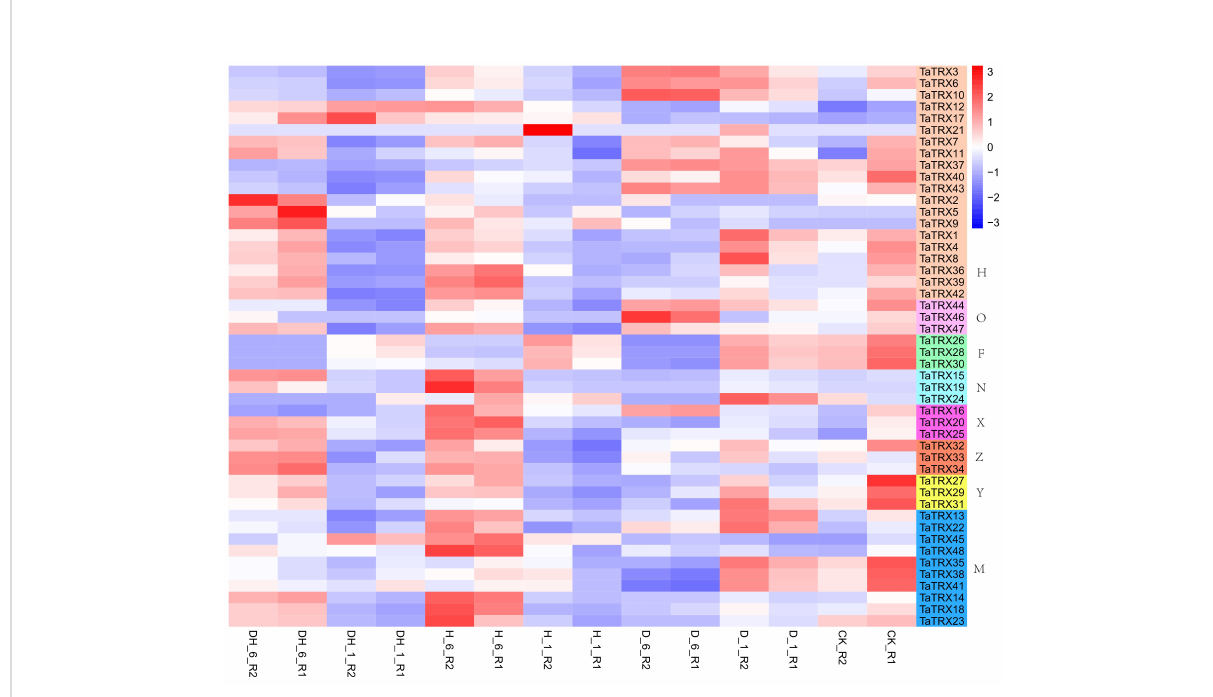
FIGURE 6 Expression pro fi les of typical TaTRX genes in wheat before and after drought stress, heat stress and co-drought and heat stress. D_1 and D_6 represent 1h and 6h after drought stress treatment of wheat respectively; H_1 and H_6 represent 1h and 6h after hot stress treatment of wheat respectively; DH_1 and DH_6 represent 1h and 6h after co-drought and heat stress treatment of wheat respectively; CK represents no stress treatment of wheat. The red, white and blue cells represent the highest, medium and lowest gene expression levels, respectively. H, O, F, N, X, Z, Y, and M represent different subtypes of typical TaTRX genes, respectively. The colour scale represents Log2 expression